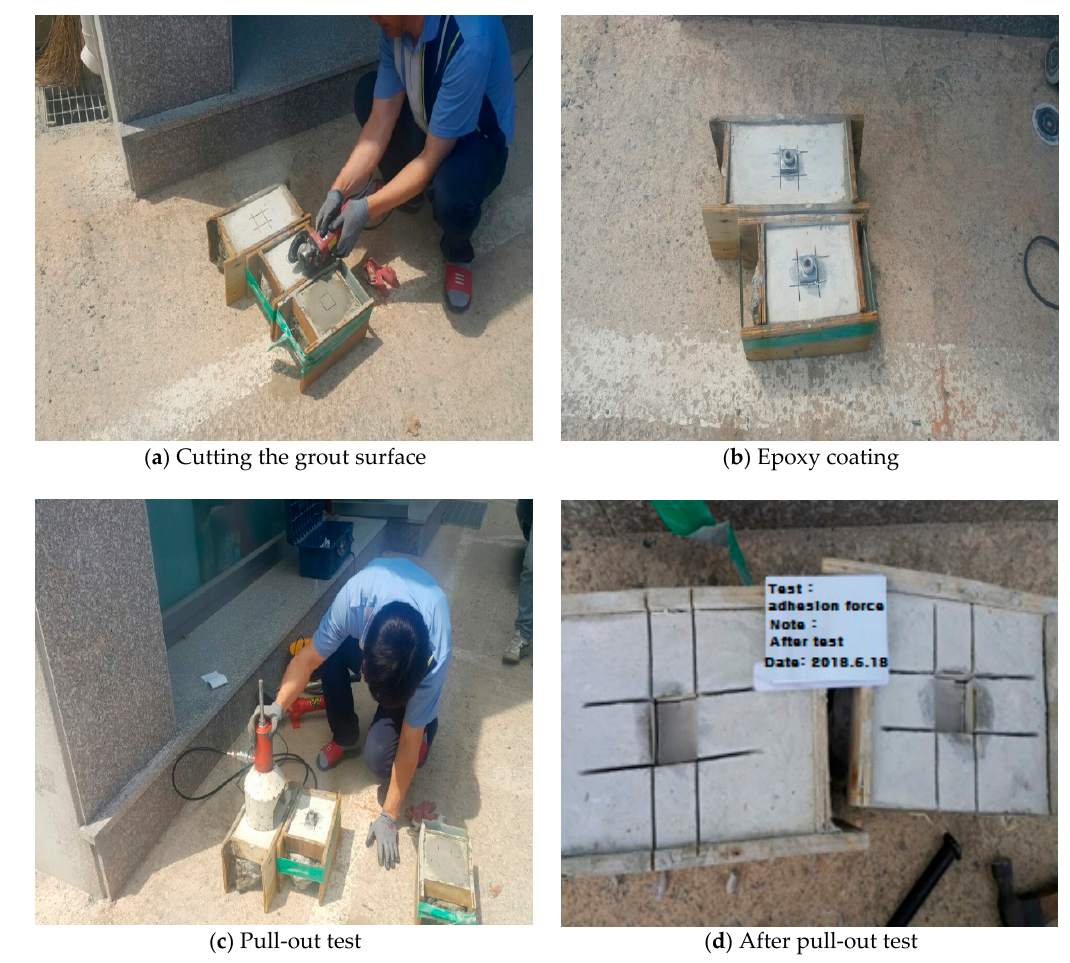
Figure 6. A view of the test to check the adhesion force.